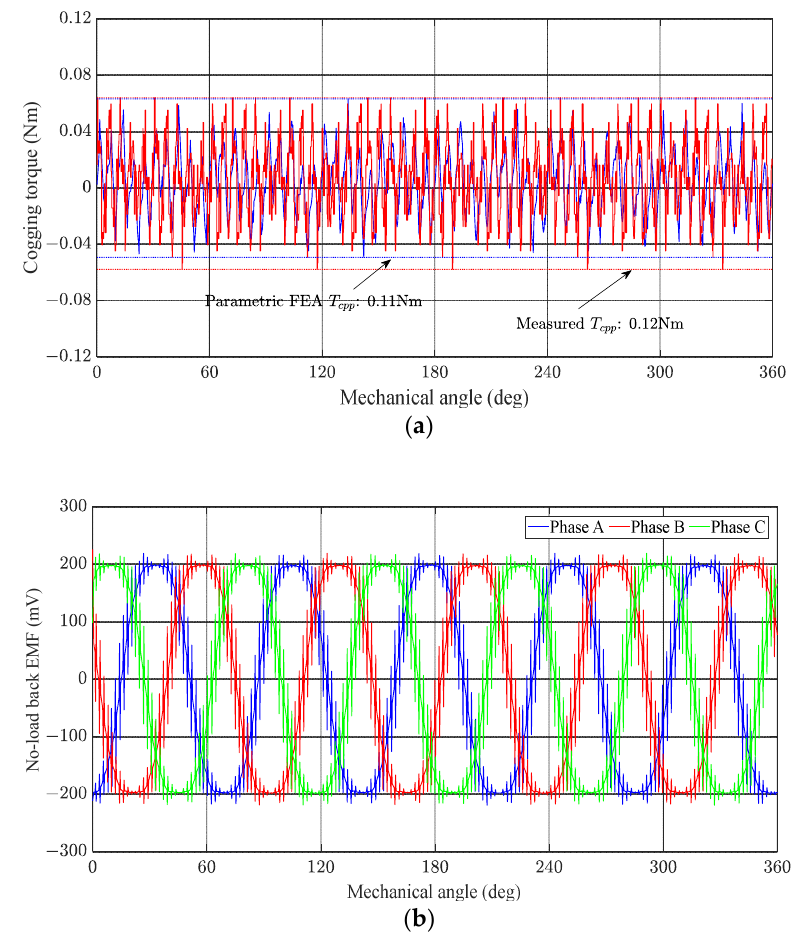
Figure 11. The electrical characteristic of the PMSM: ( a ) cogging torque waveform (measured and parametric FEA results); ( b ) no-load back EMF .